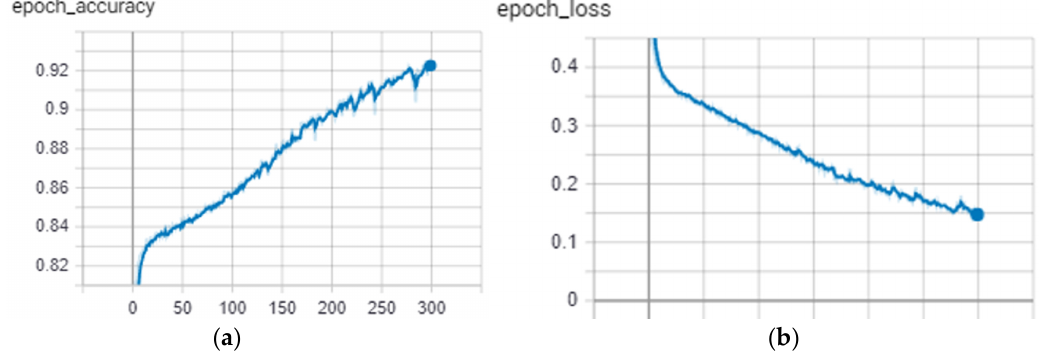
Figure 6. ( a ) Epoch accuracy ( a ) and loss ( b ) of the Adam optimizer with 300 epoch count. (2) Epoch count—50, Optimizer—Adagrad